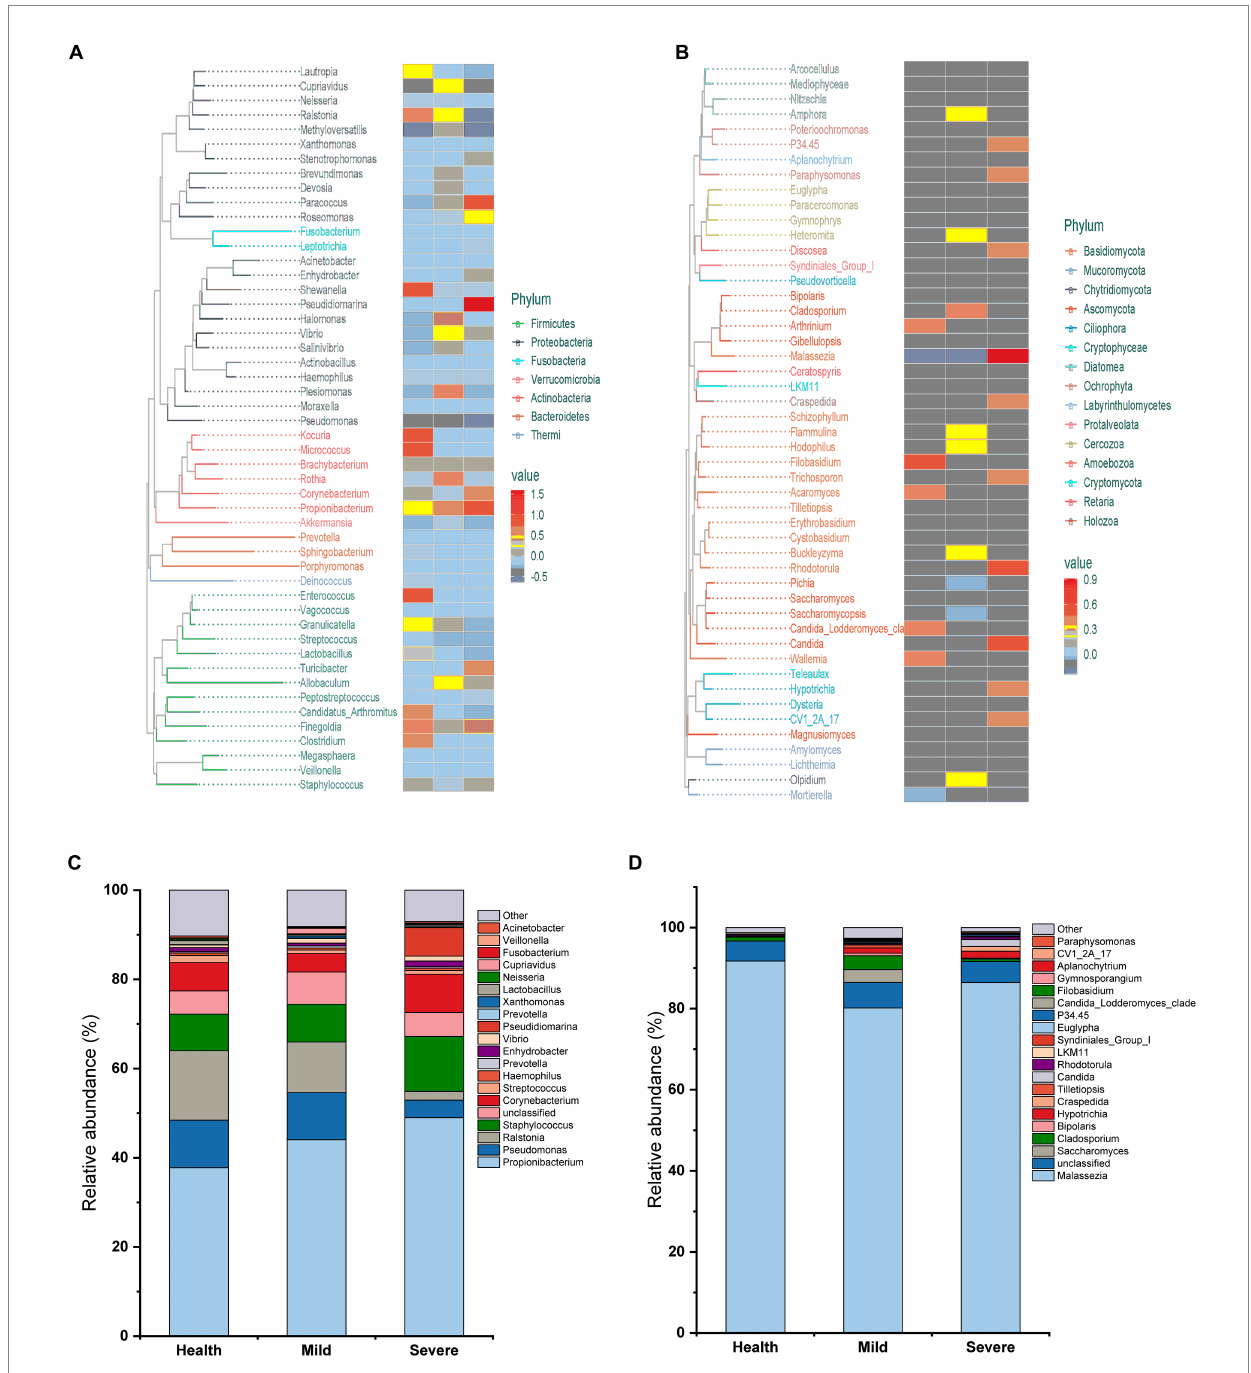
FIGURE 2 The composition of skin microbiota in different groups at the phylum and genus level. (A) Evolutionary tree for bacteria flora. (B) Evolutionary tree for fungal flora. (C) The top 20 genera in bacteria flora. (D) The top 20 genera in fungal